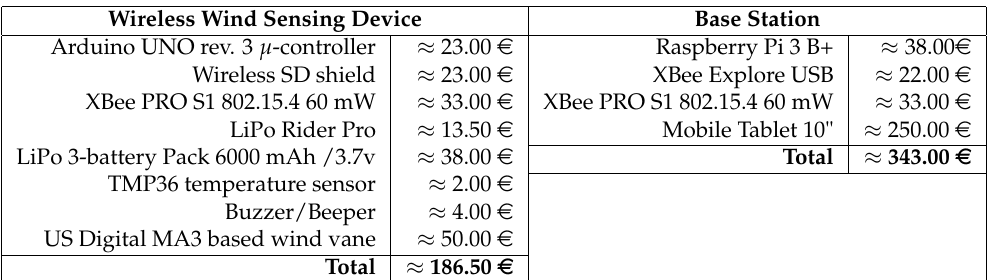
Table 3. Cost of